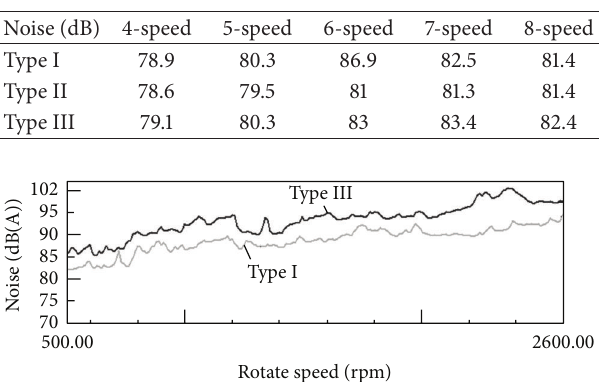
Table 1: The pass-by noise values of assembling the three gearboxes.